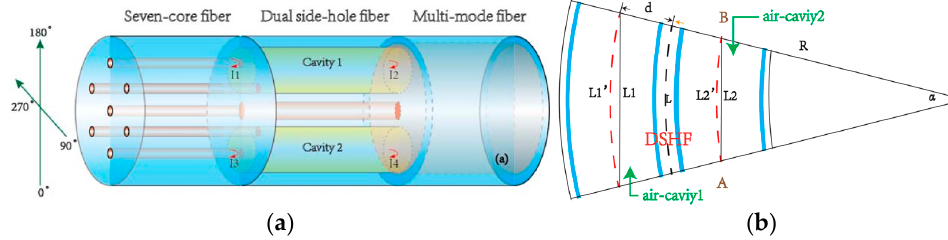
Figure 4. ( a ) Schematic of the dual air ‐ cavity FPI and ( b ) a schematic diagram of bending [13].